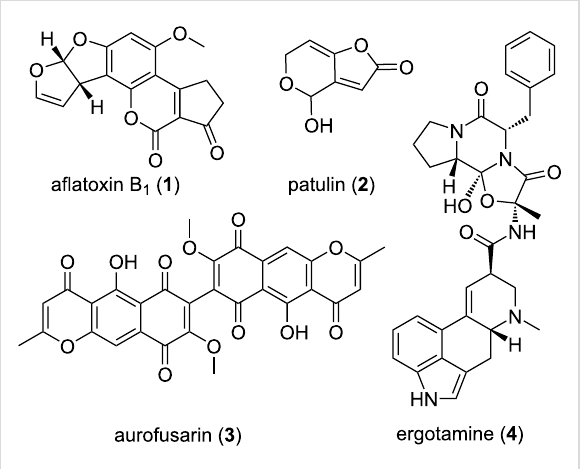
Figure 2: Fungal derived bioactive natural compounds with ecological and/or economic relevance.